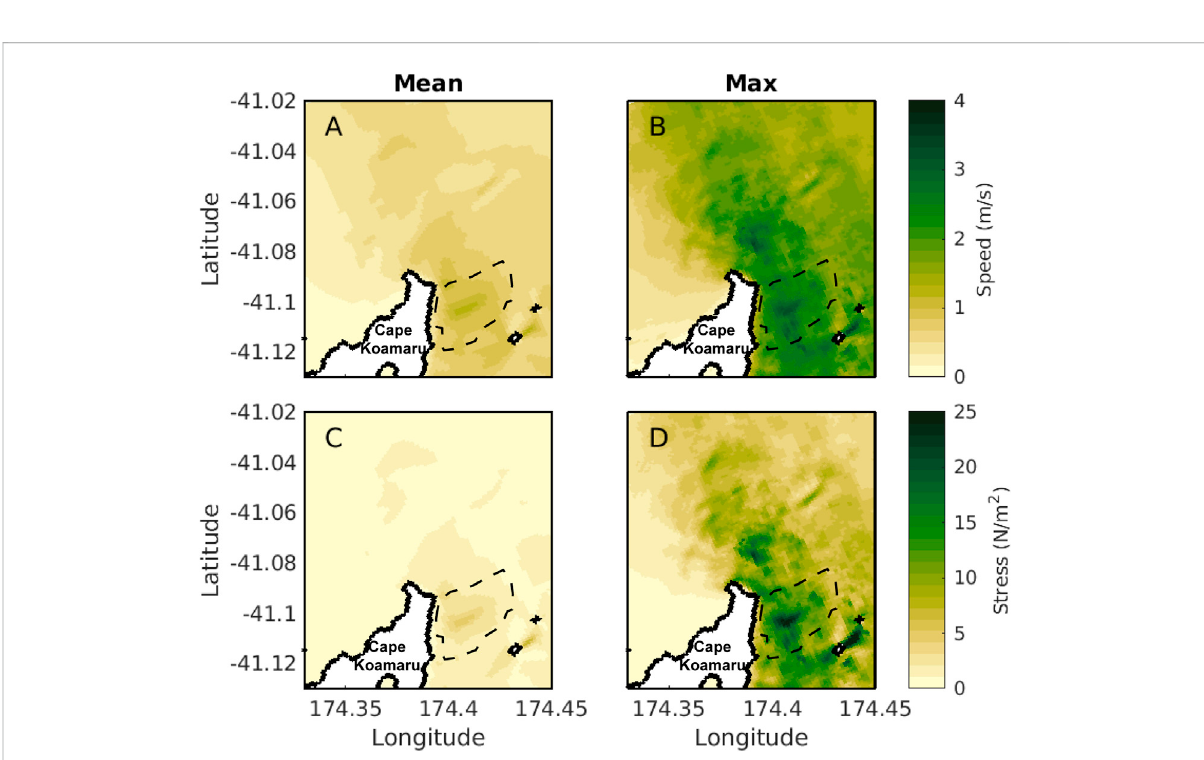
FIGURE 7 Modelled mean (A) and maximum (B) near-bottom current speed (m s − 1 ). Modelled mean (C) and maximum (D) bottom stress (N m − 2 ) in the study area. Black dashed lines outline the area where the bedforms are located (see Figure 1 for